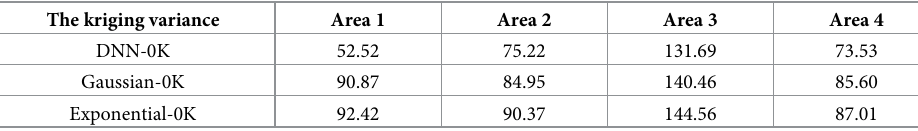
Table 3. Comparison of the mean of the kriging variance in the four